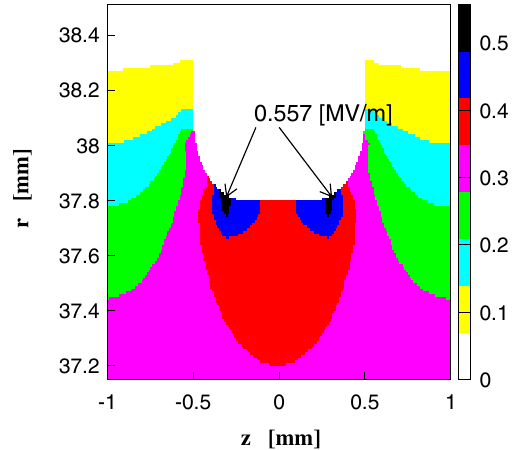
FIG. 10. Peak electric field (in MV = m ) as functions of z and r around the groove for a pitch of 2.0 mm and a depth of 1.4 mm for an input rf power of 1 MW (CW), obtained by the simulation using GDFIDL . The maximum field value is 0 : 557 MV = m near the